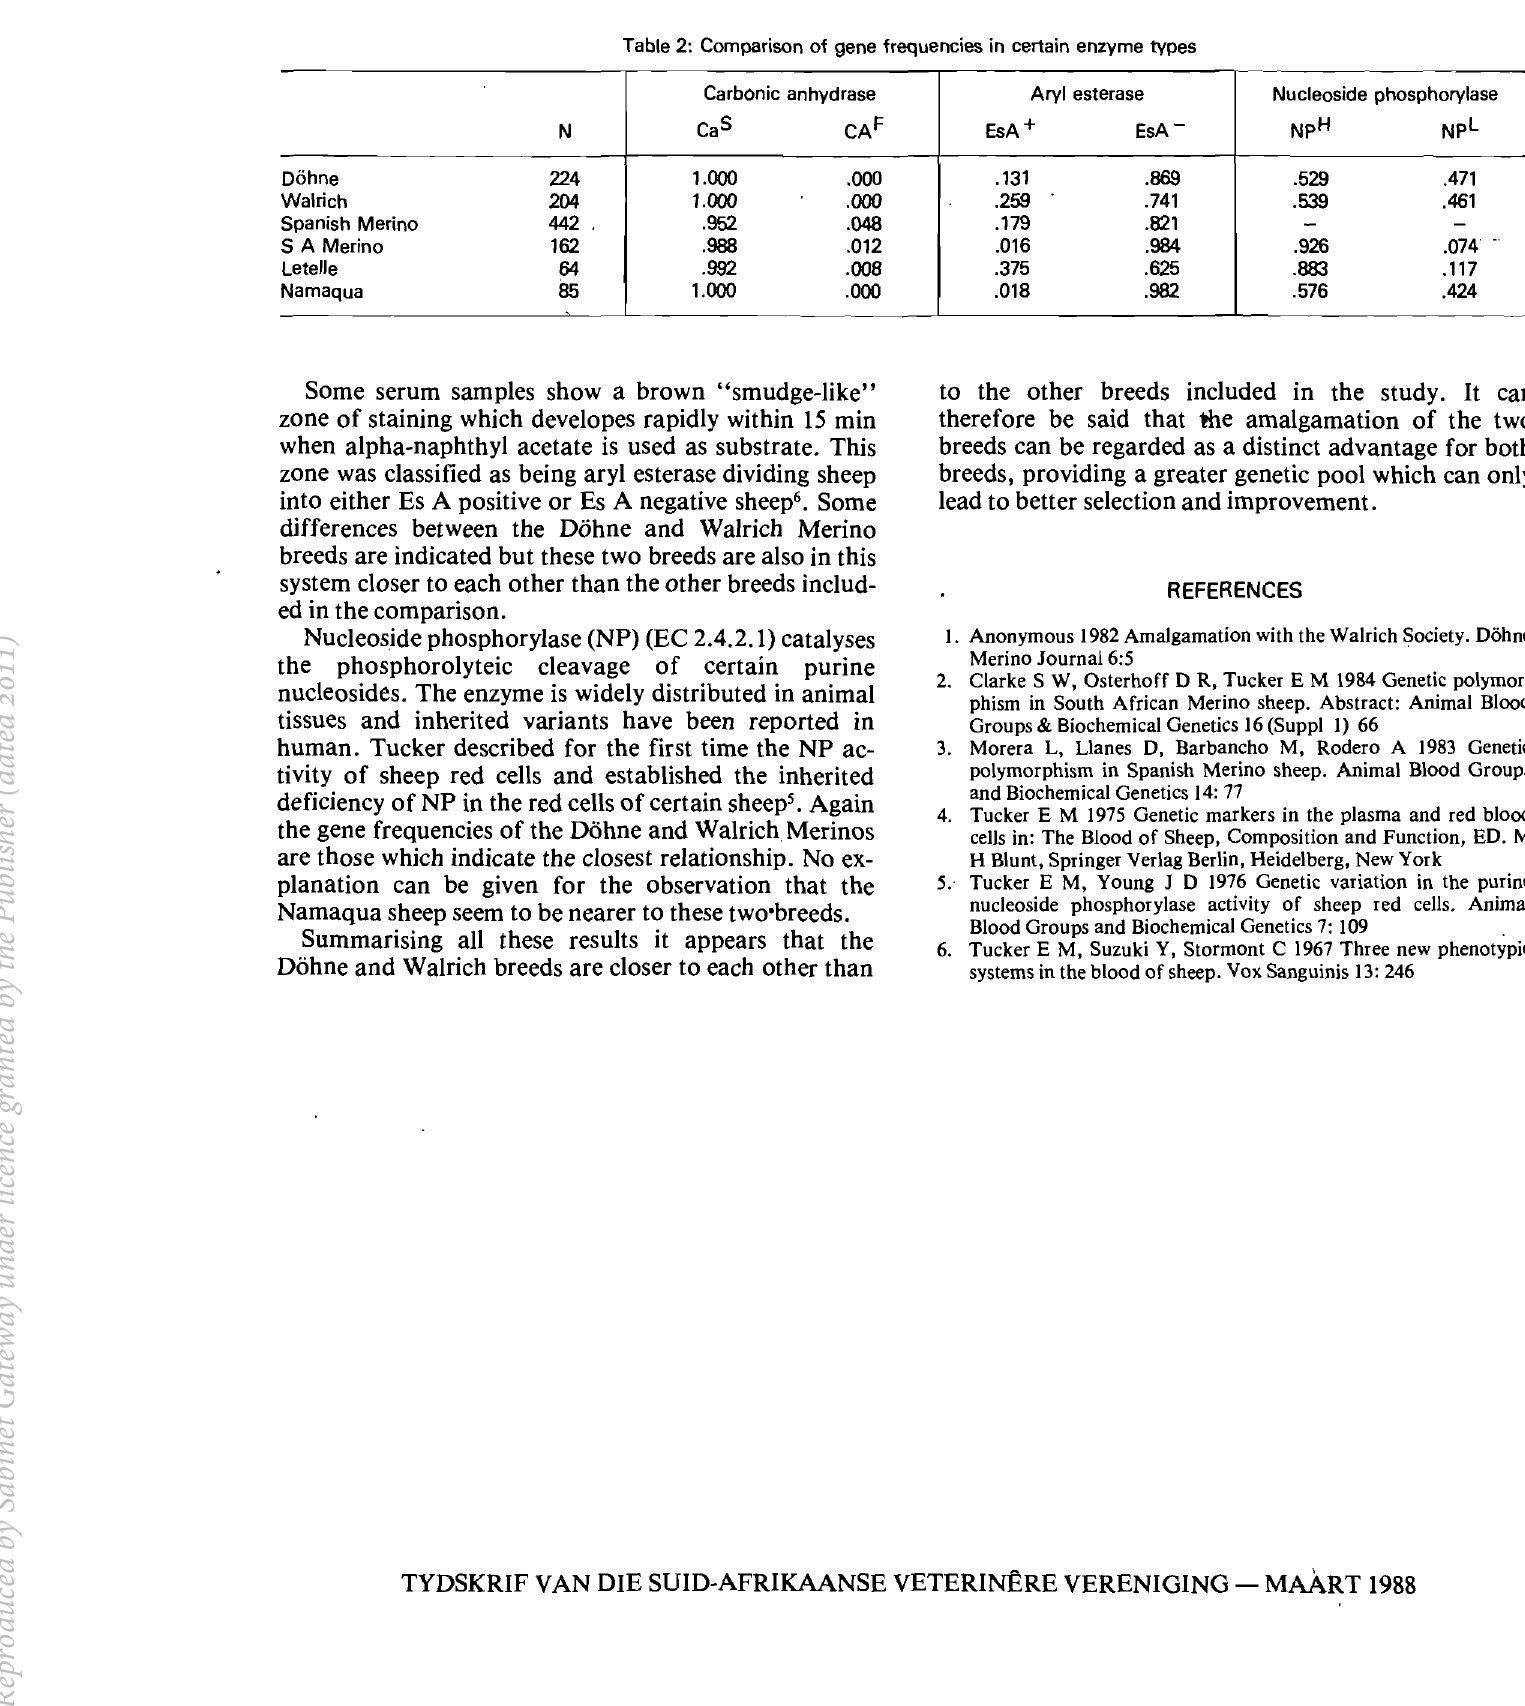
Table 2: Comparison of gene frequencies in certain enzyme